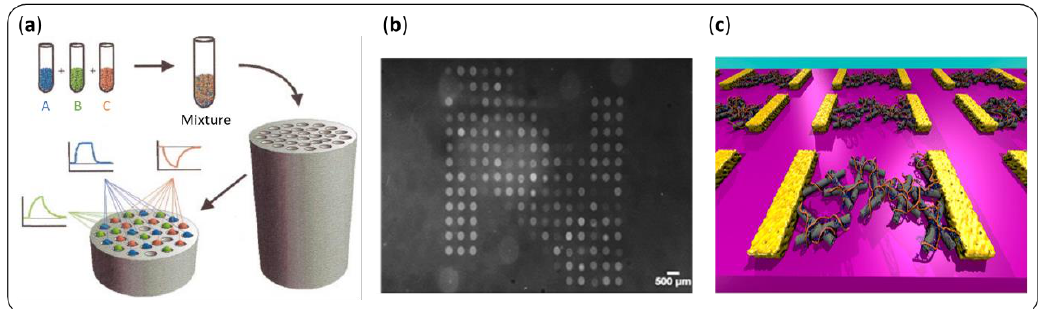
Figure 10. Multiplexing the sensors is key to achieve high sensitivity and selectivity of an artificial nose. ( a ) Dickinson et al. [159] proposed a fiber optic bead sensor array. ( b ) Brenet et al. [161] constructed a microarray and used surface plasmon resonance imaging (SPRi) for VOC sensing in the gas phase. ( c ) Kybert et al. [63] integrated numerous graphene field effect transistors (FETs) on a small chip.